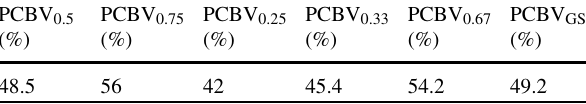
Table 11 PCBV quantiles for Gastwirth median